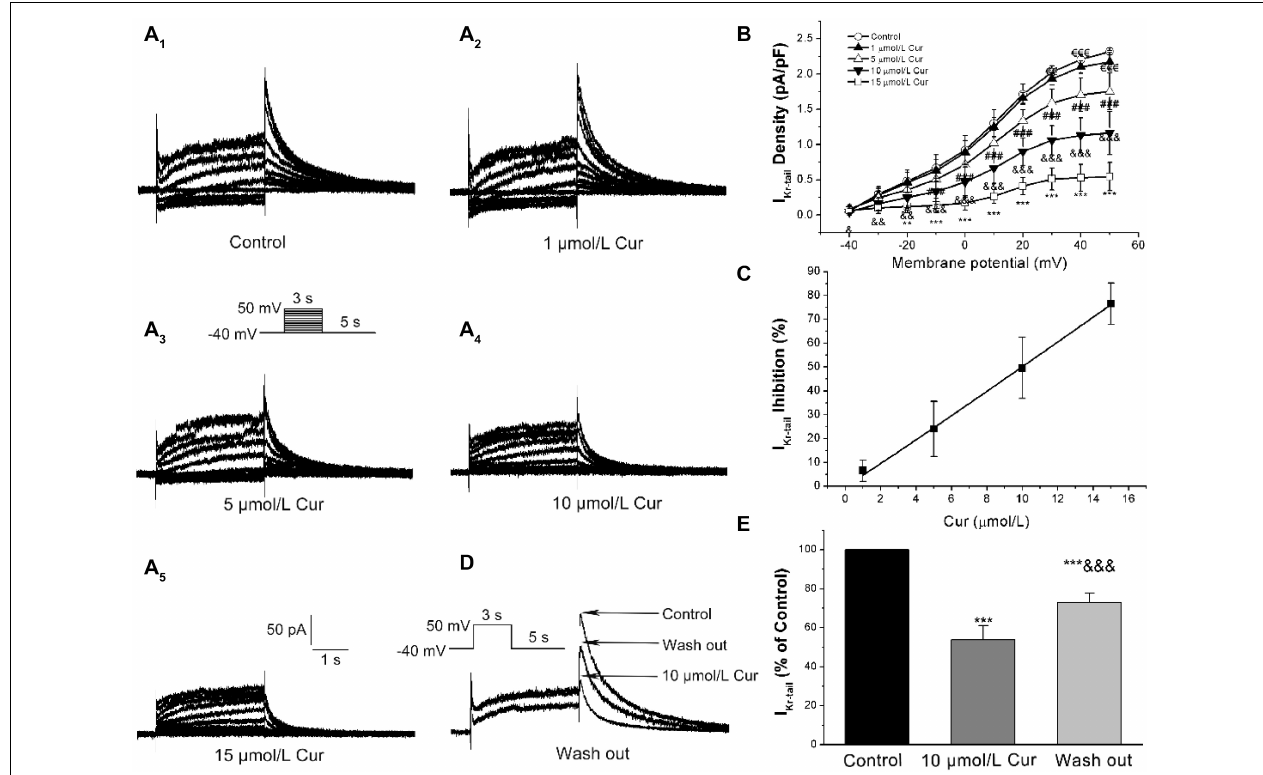
FIGURE 4 | Effects of Cur on rapidly delayed rectifying K + currents ( I Kr ) in ventricular myocytes. (A 1 –A 5 ) Example records of Cur on I Kr in different membrane potentials for the control group and Cur groups (1, 5, 10, and 15 µ mol/L). (B) The I – V relationships curves for the effects of Cur on I Kr - tail ( n = 15, ££ P < 0.01, £££ P < 0.001 vs. control; # P < 0.05, ### P < 0.001 vs. 1 µ mol/L Cur; & P < 0.05, && P < 0.01, &&& P < 0.001 vs. 5 µ mol/L Cur; ** P < 0.01, *** P < 0.001 vs. 10 µ mol/L Cur). (C) The concentration–response relationship curve of Cur on I Kr - tail , fitted with a Hill function. (D) Example records of single I Kr showing a reversible inhibitory effect of Cur on I Kr - tail . (E) The comparison of average I Kr - tail percentage values of three groups ( n = 8, *** P < 0.001 vs. control, &&& P < 0.001 vs. 10 µ mol/L Cur).